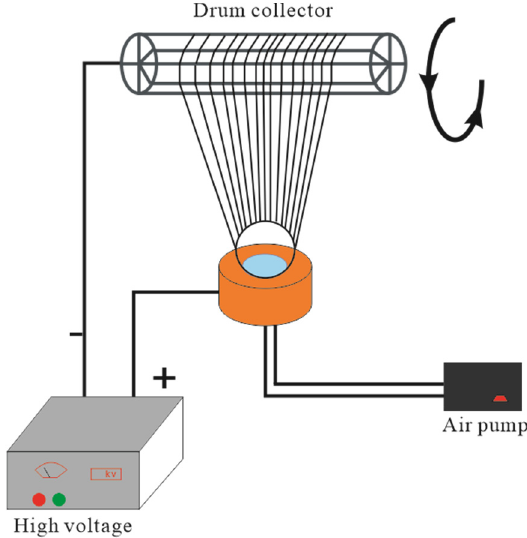
Figure 3. Bubble elctrospinning device.